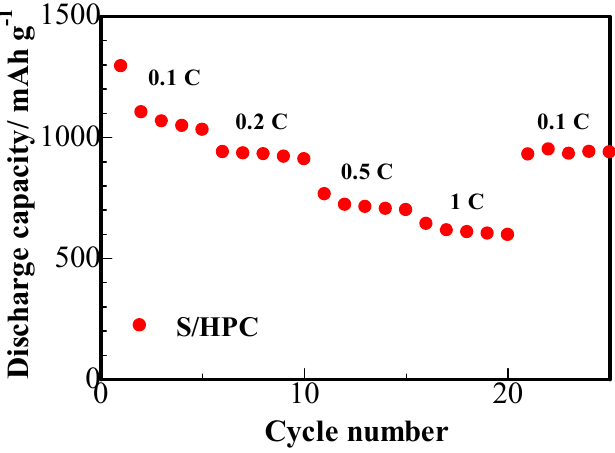
Figure 9. Rate capability of the lithium cells with S/HPC composite cathode.